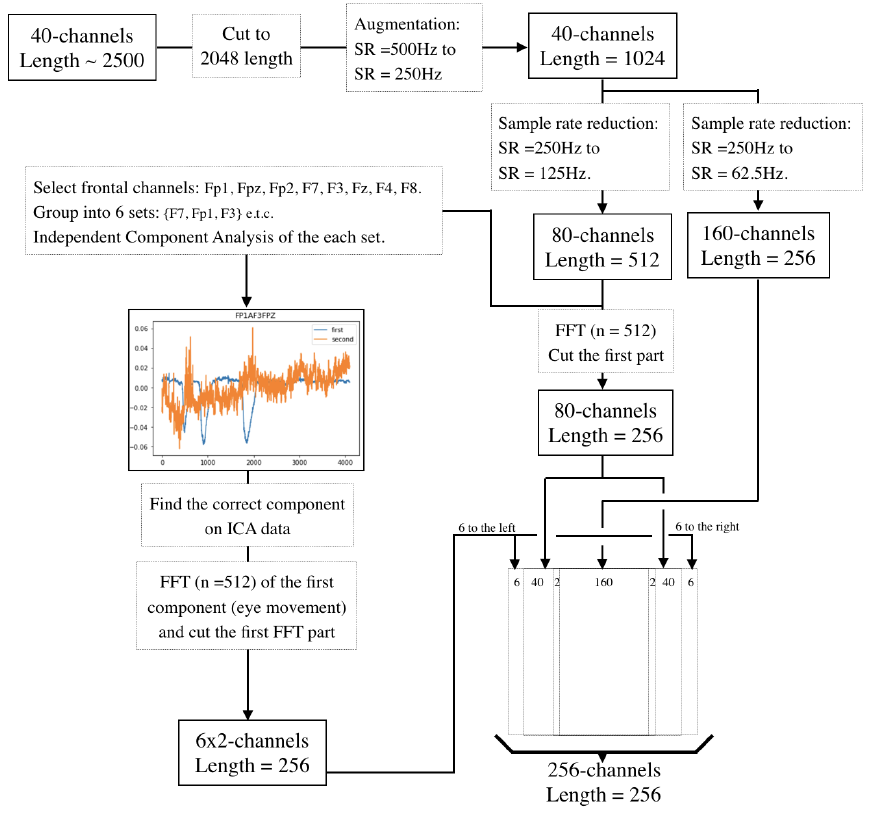
Figure 8. Presenting EEG-data as two-dimensional